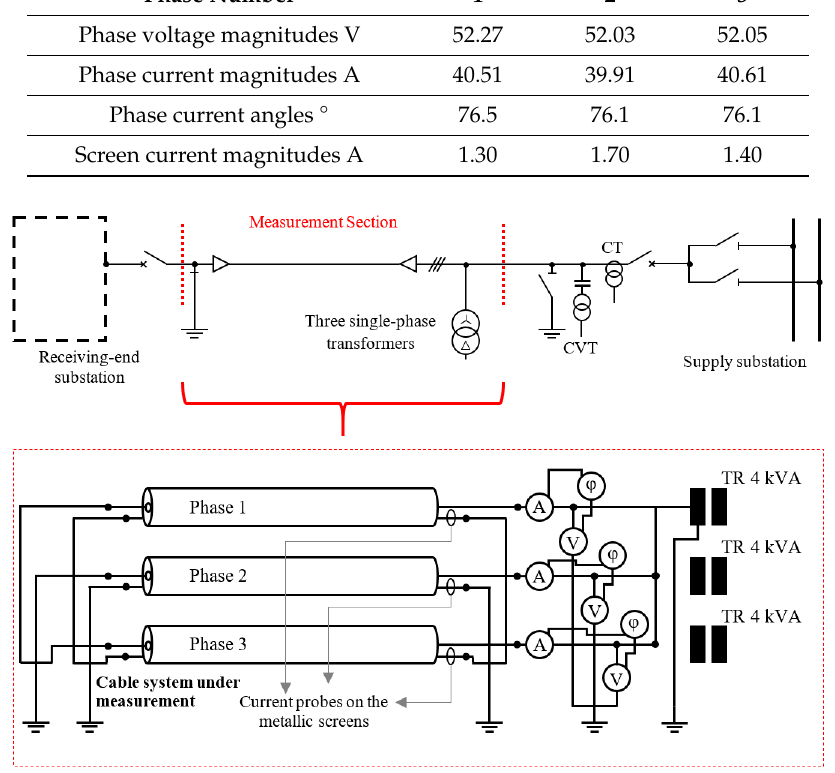
Figure 4. Equipment for measuring the zero sequence impedance. CT and A—current transformer; CVT and V—capacitor voltage transformer; ϕ —phasemeter .